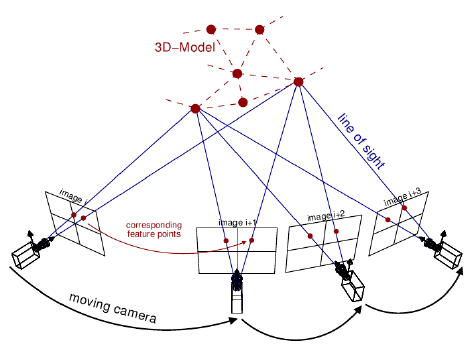
Figure 1. Structure from